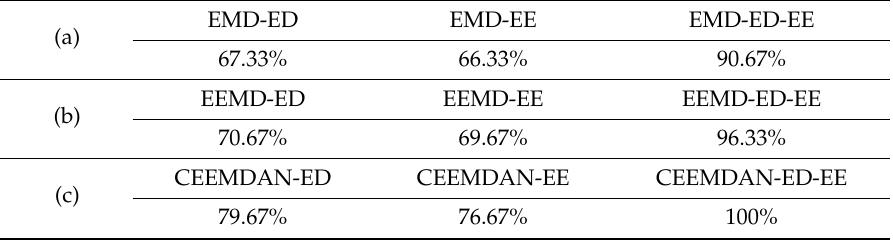
Table 3. The classification results for S-RN signals. CEEMDAN: complete ensemble empirical mode decomposition with adaptive noise; EMD: empirical mode decomposition; EEMD: ensemble empirical mode